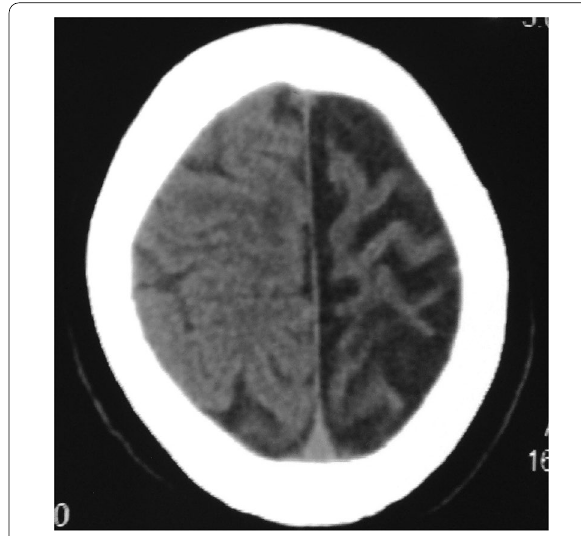
Fig. 1 Brain CT scan showing progressive left cerebral atrophy